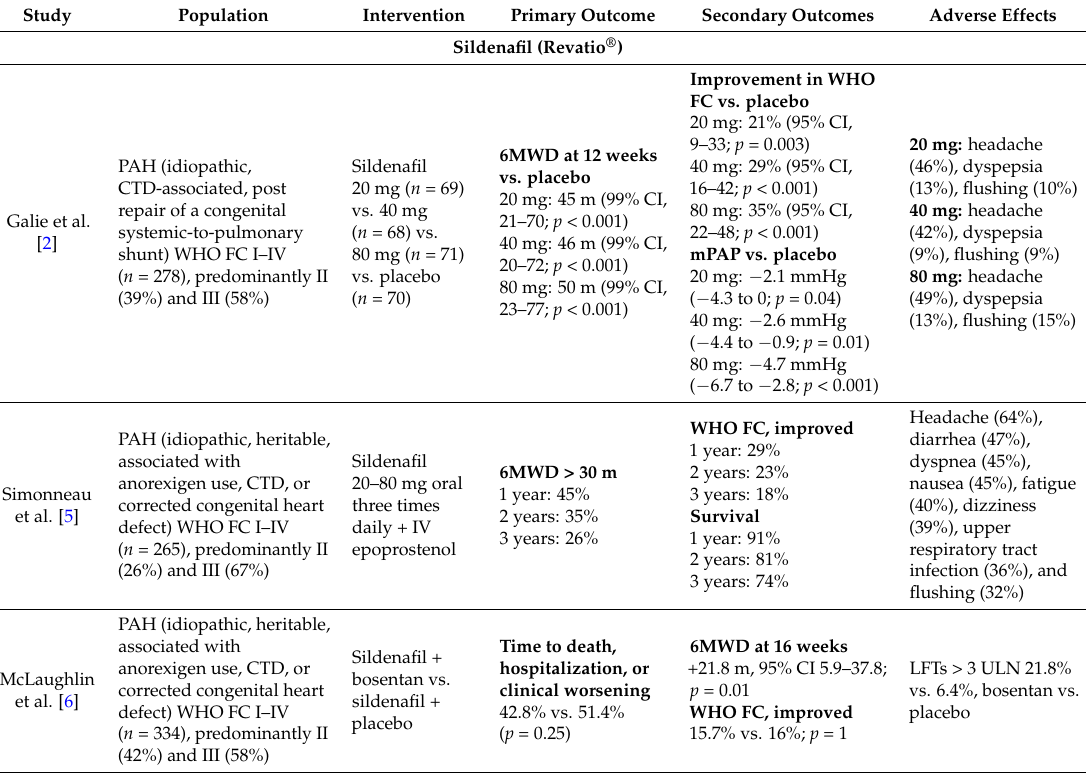
Table 1. Phosphodiesterase Type 5 Inhibitors Clinical